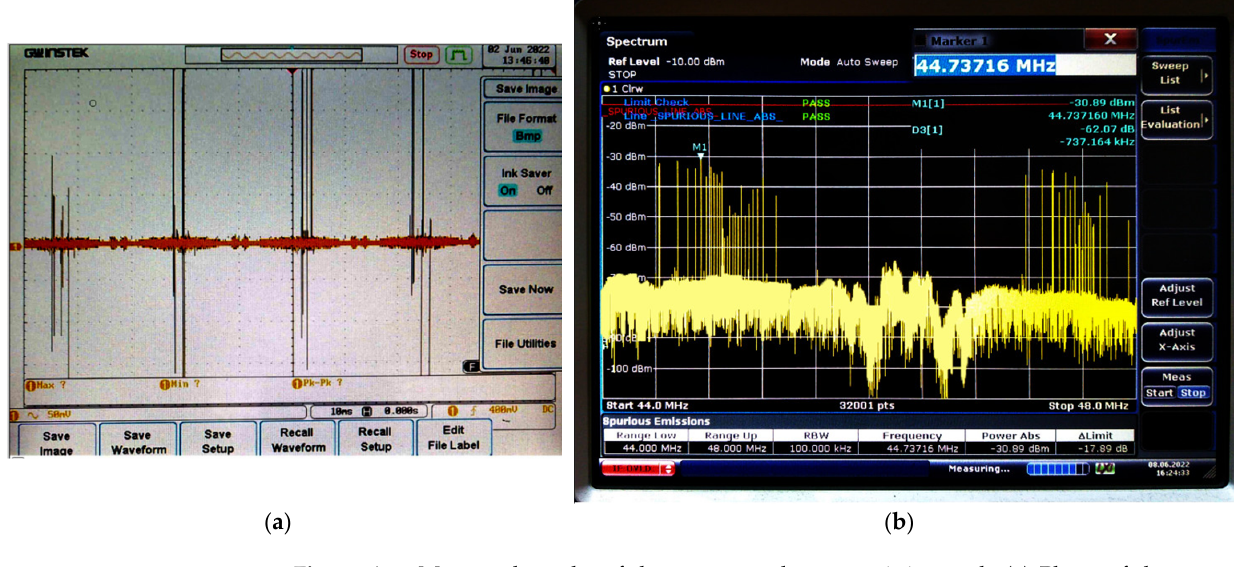
Figure A1. Measured results of the power at the transmitting end: ( a ) Photo of the measured waveform of the current measured at the transmitting end. ( b ) Photo of the spectrum at frequencies in the neighborhood of the peak harmonic component.